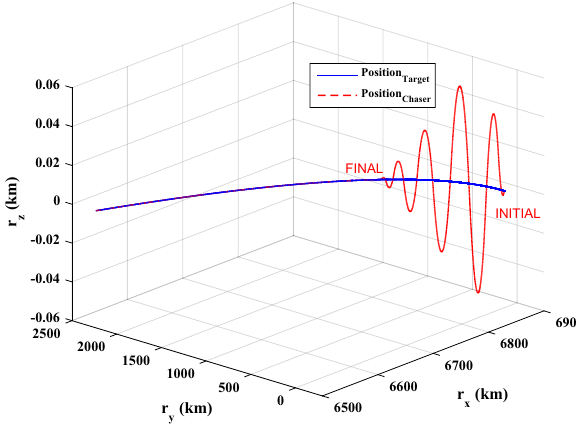
Figure 31. Scenario I: position of target and chaser spacecraft in ECI frame.